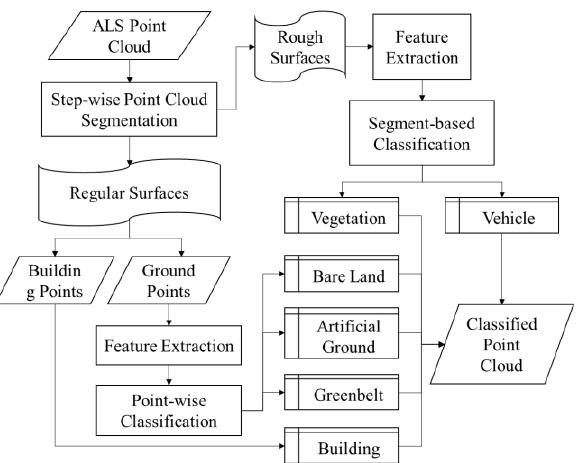
Figure 1. The workflow of the proposed multiple-primitives- based hierarchical classification